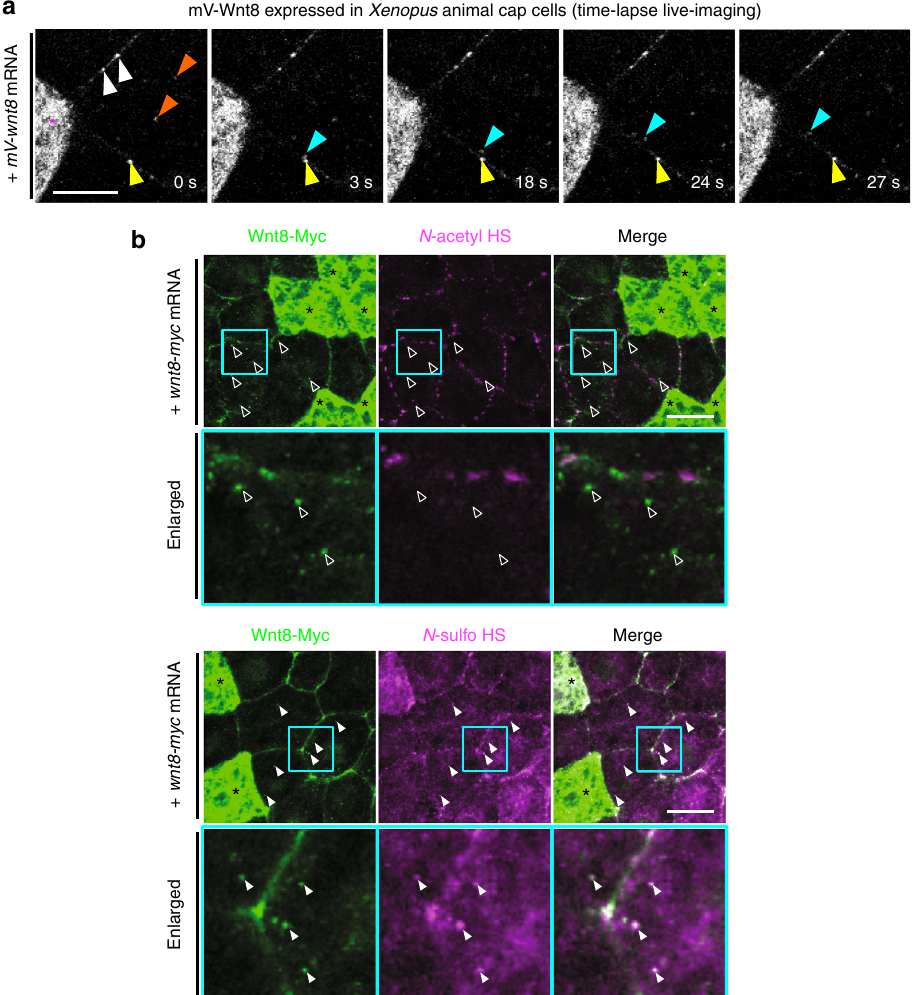
Fig. 7 Involvement of the N- sulfo-rich HS clusters in Wnt8 internalization. a Time-lapse imaging of internalization of mV-Wnt8 puncta. Subapical region (basal to the tight junction) of the super fi cial cell of the Xenopus gastrula (st. 11.5) was observed. In the vicinity of mV-Wnt8 expressing cells (asterisk), puncta at the cell boundary (white and yellow arrowheads) and inside cells (orange arrowheads) were observed. The time point of each picture was as indicated. A budding and subsequently internalized punctum (tracked by a cyan arrowhead) was generated from a punctum (yellow arrowhead) on the cell membrane. See also Supplementary Movie 1. b Colocalization of internalized puncta of Wnt8 with N- sulfo-rich HS clusters. Wnt8-Myc expressing cells were as indicated (*), and the others were receiving cells. The puncta of Wnt8-Myc inside cells near Wnt8-Myc expressing cells are considered to be internalized, because the subapical region (basal to the tight junction) but not the apical cell surface was observed (arrowheads or open arrowheads). Upper panels, co-immunostaining of Wnt8-Myc and N- acetyl HS. Staining of N- acetyl HS was absent from internalized puncta of Wnt8-Myc (open arrowheads). Lower panels, co-immunostaining of Wnt8-Myc and N- sulfo HS. Colocalization of N- sulfo-rich HS clusters and Wnt8-Myc inside cells (arrowheads) was observed, suggesting involvement of N- sulfo-rich HS cluster in Wnt8 internalization. Images are a representative of at least two independent experiments. Amounts of injected mRNA (ng/embryo): mV-wnt8 , 1.0; wnt8-myc , 0.25. Scale bars, 10 μ m ( a ); 20 μ m ( b ( r = 0.186) (Fig. 9a). The preference of Frzb for N- acetyl-rich HS clusters was veri fi ed by several lines of evidence as follows. Firstly,